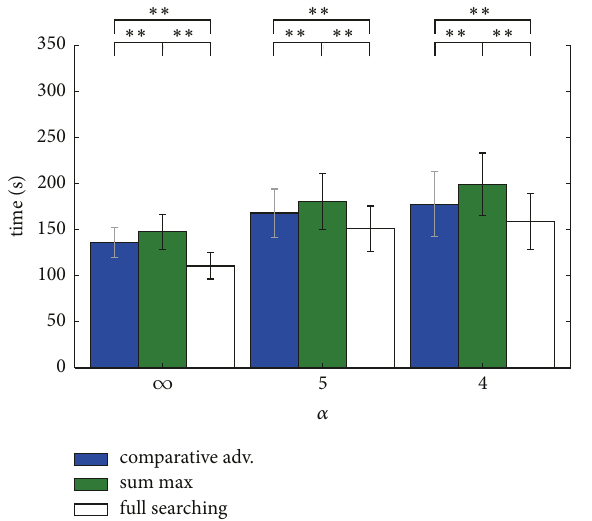
Figure 25: Makespan in situations where carrying objects are added later (four robots). ∗∗ 𝑝 < .01 , ∗ 𝑝 < .05 , and + 𝑝 < .1 . A significant 𝑝 value indicates that a significant difference in prescribing exists between the conditions. The lower 𝑝 value indicates a strong significant difference. n.s. means no significant difference between the conditions.